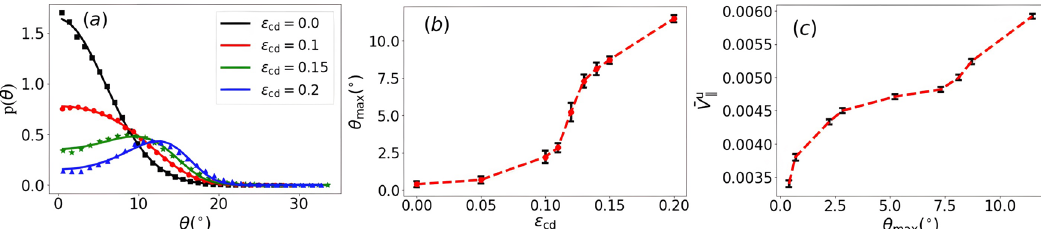
Fig. 3 The dependencies of the tilt angle and self-propelled velocity. a The probability distribution p ( θ ) versus tilt angle θ for various values of ϵ cd for a backward-moving torus with g = 0.15. The symbols are the simulation data and the solid lines are fi t according to Eq. (7) with fi t parameters γ 1 and γ 2 . ( ϵ cd : βγ 1 , γ 2 ): (0.0:94, 0), (0.1:1635, 0.988), (0.15:3132, 1.015), (0.2:3686, 1.024). b The dependence of the tilt angle θ dipole interactions ϵ cd . c The torus velocity (cid:2) V u k versus the tilt angle θ max . The probability distributions were constructed from 30 – 50 realizations of the dynamics. The symbols are the mean values from the 30 – 50 realizations, and the error bars are the standard